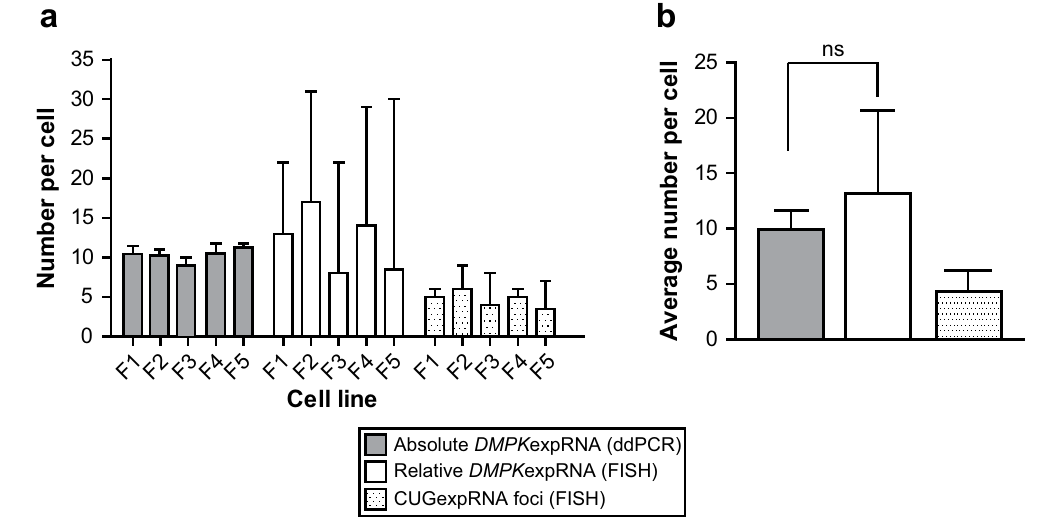
Figure 7. Comparative Analysis of Mutant DMPK mRNA Copy Numbers in Human DM1 Fibroblasts via ddPCR and FISH. ( a ) The absolute numbers of mutant DMPK mRNA based on ddPCR results are presented in comparison with FISH estimated relative numbers of the transcript in five DM1 fibroblast cell lines. Plotted are also the numbers of CUG exp RNA foci per nucleus. The median values ± SD for each data set are shown. ( b ) The average numbers of mutant DMPK RNA and CUG exp RNA foci in five DM1 fibroblast cell lines. Data are presented as mean ±